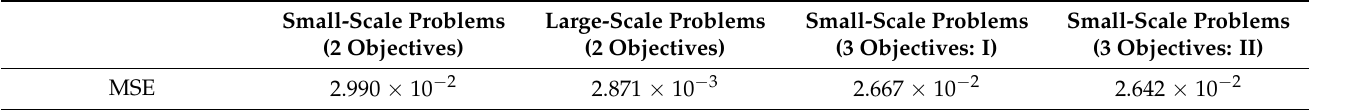
Table 9. MSE results of machine